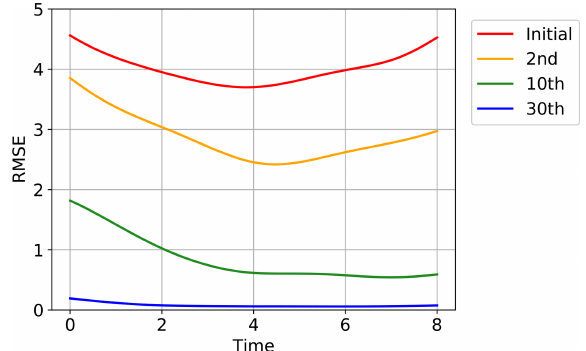
Figure 6. The root mean square errors over all the 40 variables at each time step for the initial guess (red line), the second iteration (yellow line), the 10th iteration (green line), and the 30th iteration (blue line) in the same trial as Fig. 5.